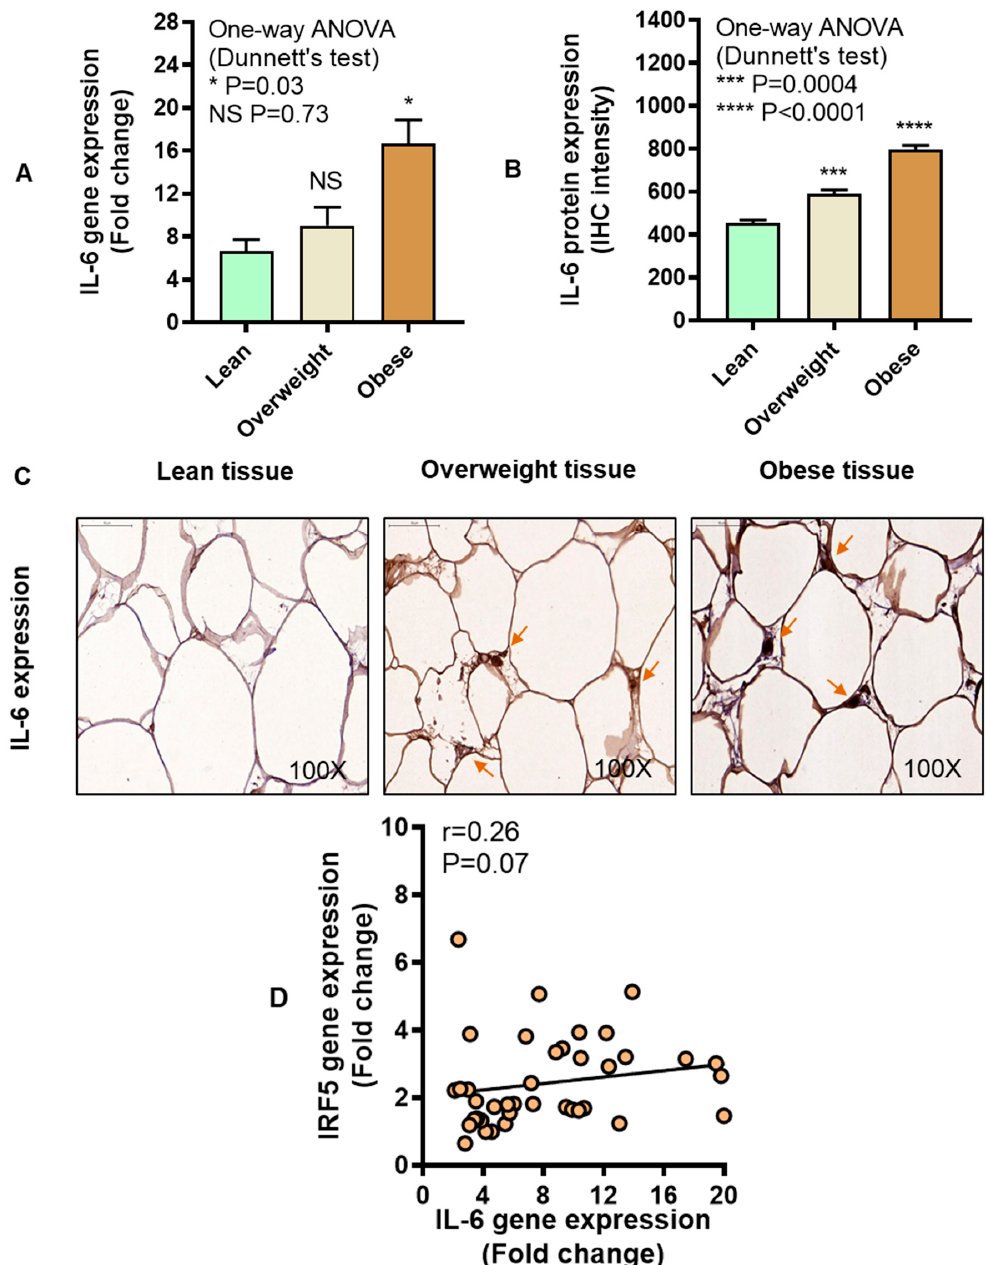
Figure 4. Elevated adipose interleukin-6 (IL-6) expression in obesity. Adipose tissue IL-6 gene expression was determined in five lean, six overweight, and 19 obese non-diabetic individuals using real-time RT-PCR, while IL-6 protein expression was also determined in six lean, 14 overweight, and 10 obese non-diabetic individuals using immunohistochemistry (IHC) as described in Materials and Methods. The data (mean ± SEM) show that ( A ) IL-6 adipose gene expression was elevated in obese (P = 0.03) compared with lean individuals. ( B ) IL-6 protein expression (IHC intensity expressed in arbitrary units) was also increased both in overweight (P = 0.0004) and obese (P < 0.0001) as compared with lean individuals. ( C ) The representative IHC images obtained from three independent determinations with similar results show elevated adipose tissue IL-6 expression (brown arrows, 100× magnification) in overweight and obese as compared with lean individuals. Scale bar = 50 µM. ( D ) IRF5 and IL-6 gene expression did not correlate in the adipose tissue (r = 0.26, P = 0.07). The asterisks *, ***, and **** represent significance levels of P ≤ 0.05, P ˂ 0.001, and P ˂ 0.0001,